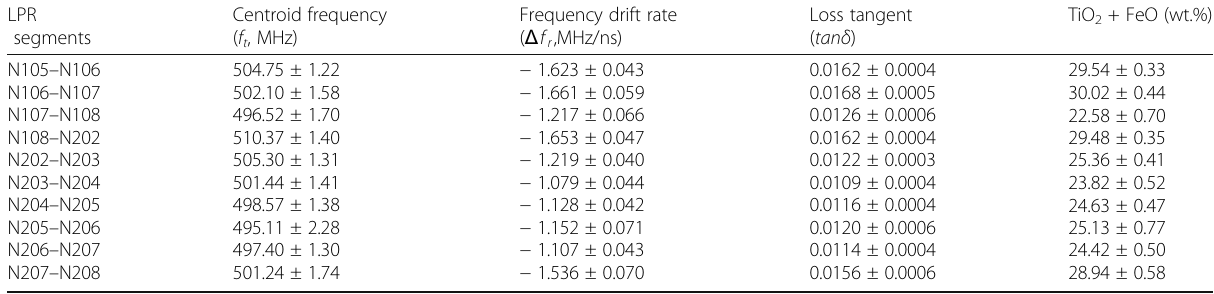
Table 1 Parameters estimation for each navigational points. The centroid frequency of the received radar signal, the drift slope of the centroid frequency, the derived loss tangent, and the derived TiO 2 + FeO contents at different segments of the LPR data. The uncertainties for all the estimated values are the 95% confidence bounds. The navigation points are shown in Figs. 1c and